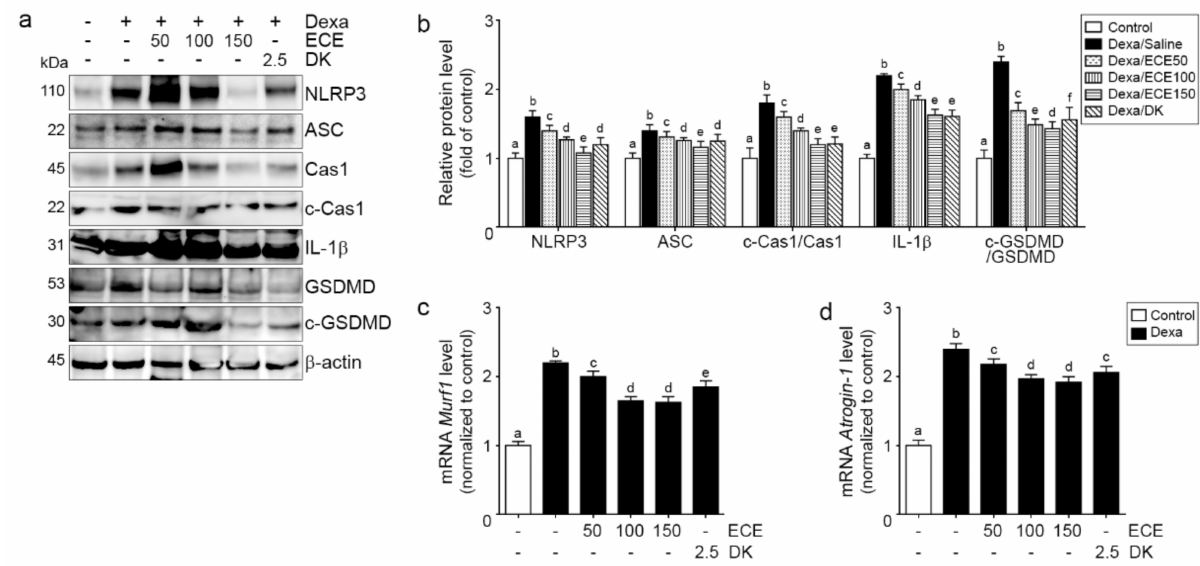
Figure 3. Effects of ECE and DK on pyroptosis by reducing NLRP3 inflammasome formation in the gastrocnemius muscle of the Dexa-induced muscle atrophy model. ( a , b ) Protein levels of NLRP3 inflammasome-pyroptosis-related molecules (NLRP3, ASC, Cas1, c-Cas1, IL-1 β , GSDMD, and cleaved GSDMD) were determined by Western blotting. As a result, NLRP3 inflammasome-pyroptosis-related molecules were increased by Dexa but decreased by ECE and DK. ( c , d ) mRNA levels of Murf1 and Atrogin-1 , related to muscle protein degradation, were increased by Dexa but decreased by ECE and DK. The dose unit of ECE and DK is mg/kg/day. a–f: Different letters indicate significant differences among groups, as determined by multiple comparison (Mann–Whitney U test); p < 0.05. ASC, adaptor molecule apoptosis-associated speck-like protein containing CARD; Cas1, caspase 1; c-Cas1, cleaved-caspase 1; c-GSDMD, cleaved-gasdermin D; Dexa, dexamethasone; DK, dieckol; ECE, Ecklonia cava extract; GSDMD, gasdermin D; IL-1 β , interleukin-1beta; NLRP3, NOD-like receptor pyrin domain-containning protein